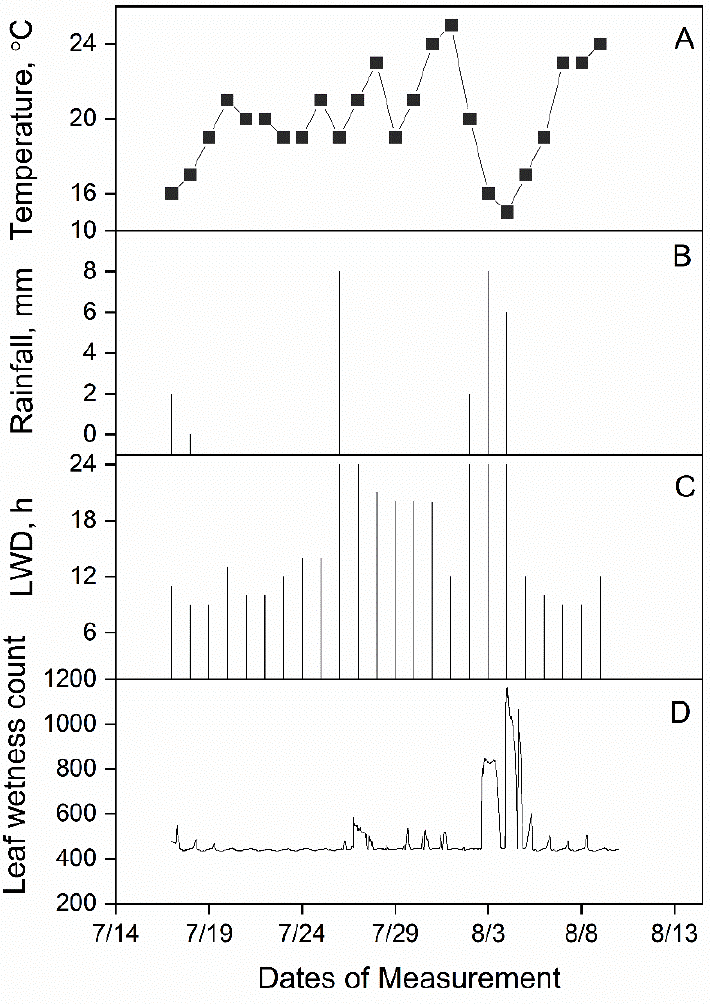
Figure 6. Average air temperature ( A ), daily rainfall ( B ), leaf wetness duration ( C ), and leaf wetness counts per day ( D ) during the measurement period.